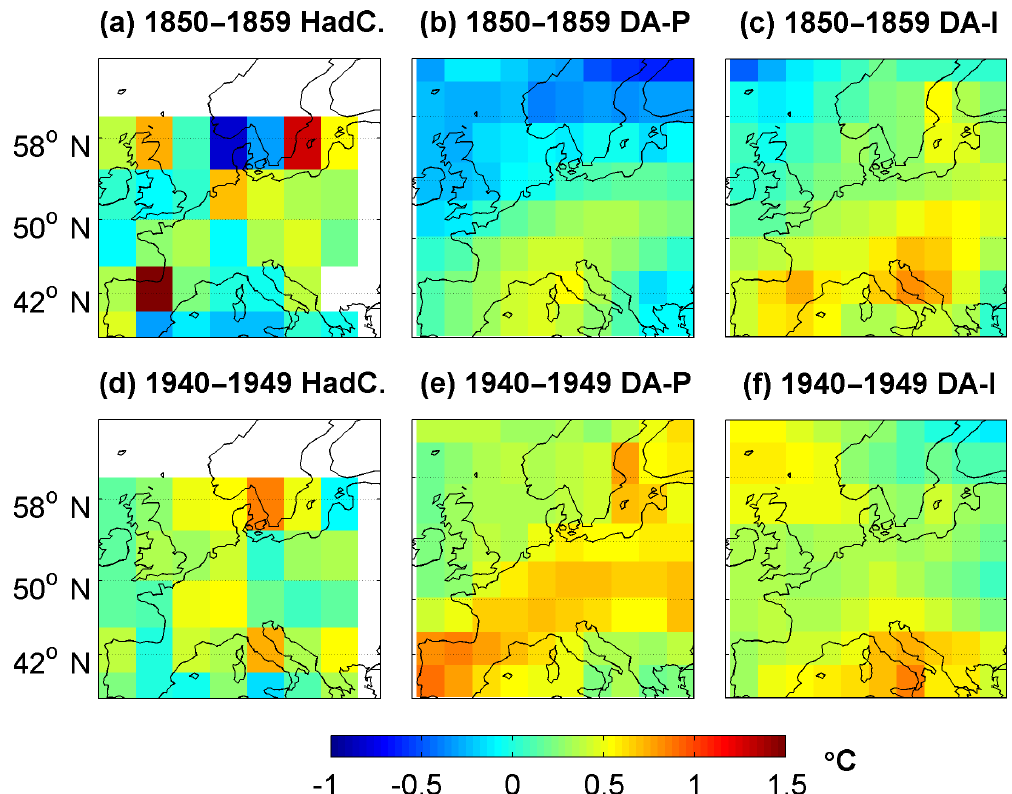
Figure 4. European decadal surface air temperatures (anomalies with respect to the 1850–1949 AD mean) for the DA-P analysis, the DA-I analysis and the HadCRUT3v reconstructions, for the summers of 1850–1859 AD and 1940–1949